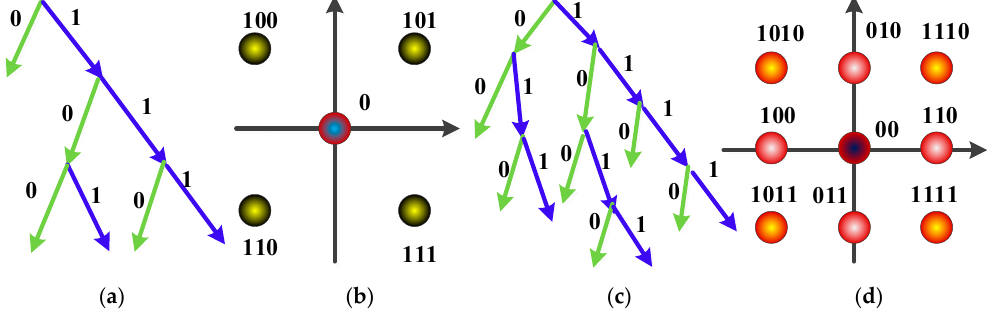
Figure 4. Huffman coding ( a ) and the constellation format ( b ) for 5-QAM; Huffman coding ( c ) and Figure 4. Hu ff man coding ( a ) and the constellation format ( b ) for 5-QAM; Hu ff man coding ( c ) and the the constellation format ( d ) for 9-QAM. constellation format ( d ) for